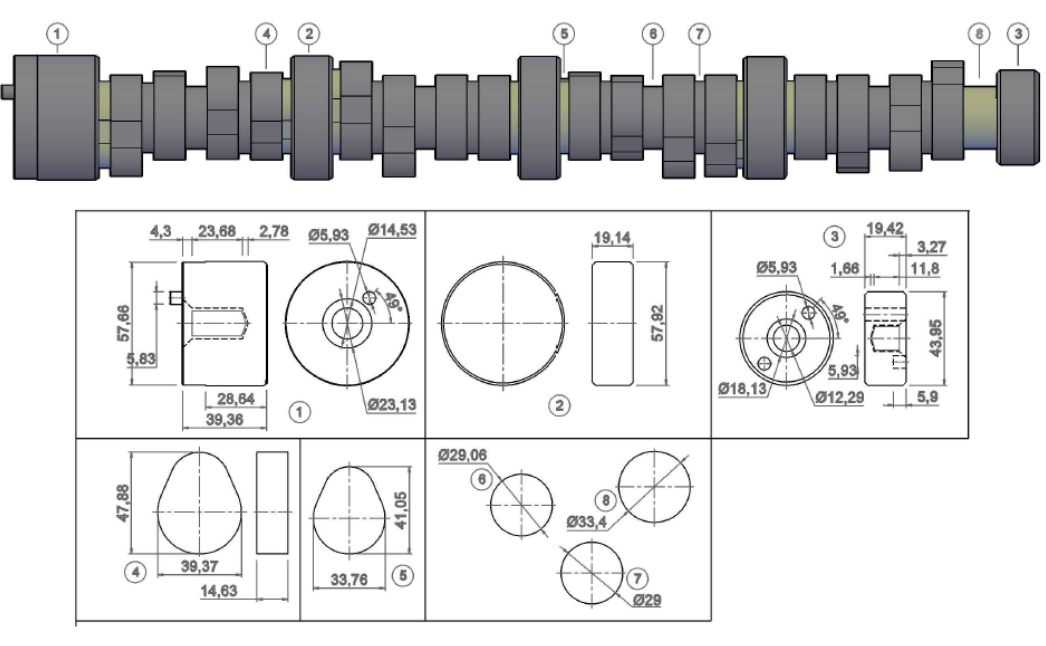
Figure 1. Camshaft geometry.